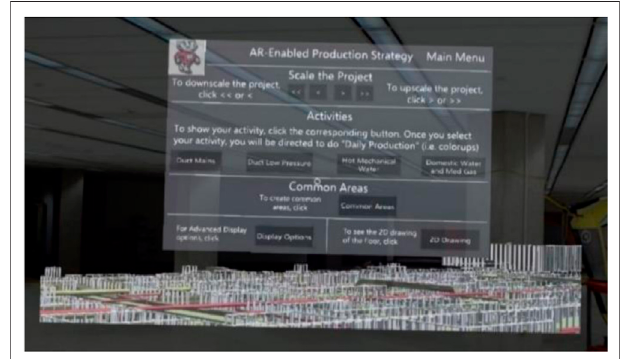
FIGURE 5 | Creation of measurements and production areas in the AR environment. Reprinted from Nassereddine (2019), fi g. 73, p.